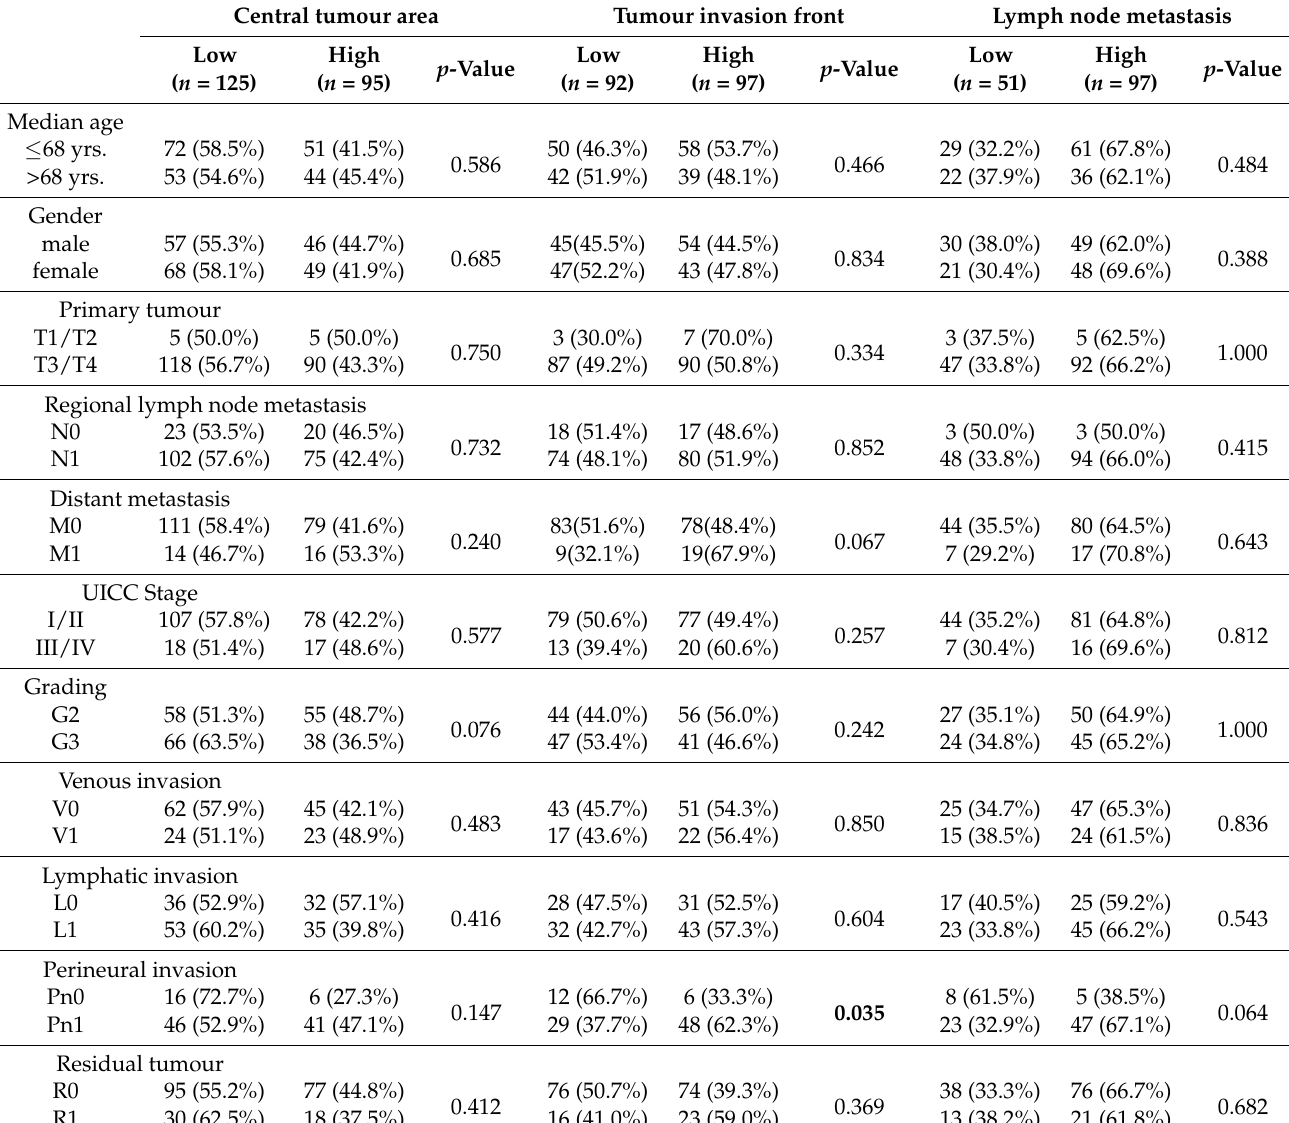
Table 2. Nuclear survivin expression 1 .